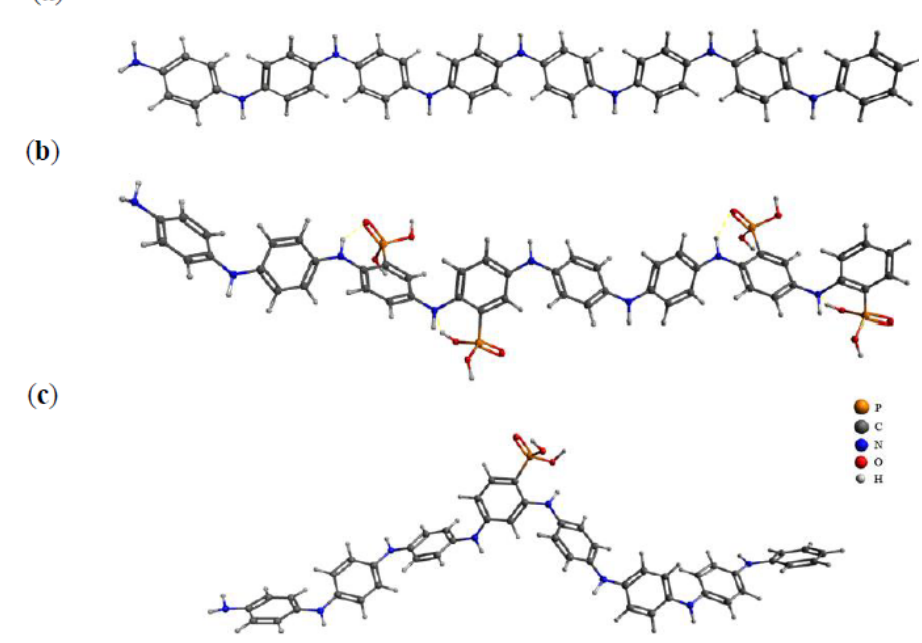
Figure 6. Most stable model structures for: ( a ) PANI, ( b ) PANI2APPA, and ( c ) PANI4APPA. H is white, C is grey, N is blue, O is red, and P is orange.